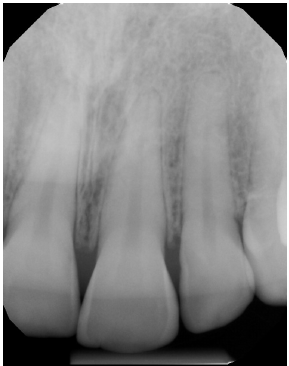
Figure A2. Palatal aspect of the region of interest after hemostasis was achieved.